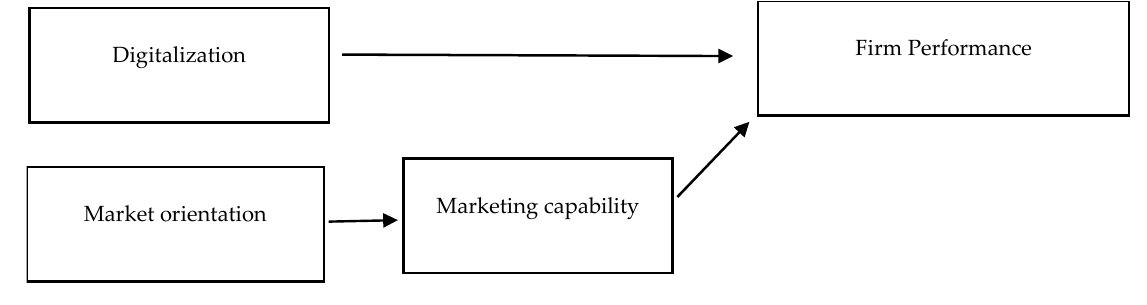
Figure 1. Theoretical model.